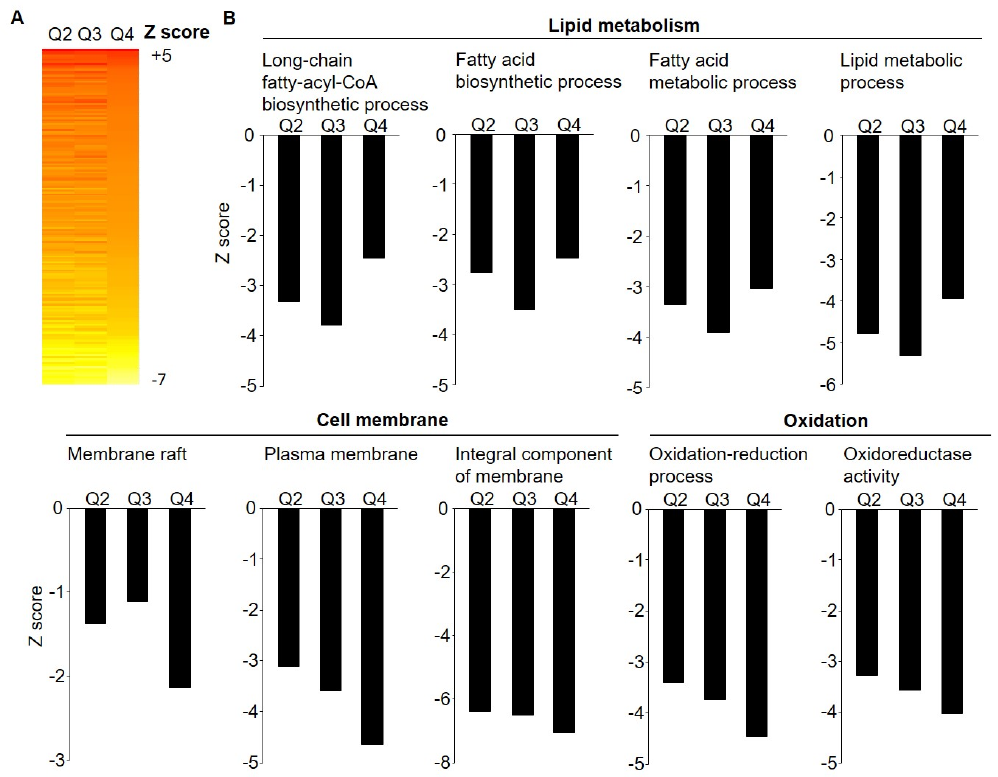
Figure 1. Effect of weight loss on SAT gene expression pathway enrichment ( n = 138). Parametric analysis of gene-set enrichment (PAGE) were performed on microarray data including 681 significantly ( p < 0.05) regulated genes across weight loss quartiles. ( A ) Heat map on biological pathways that were significantly differentially regulated by weight loss, based on the Z score for difference between weight loss quartiles with Q1 (lowest quartile) as a reference. ( B ) Biological pathways involved in lipid metabolism, cell membrane, and oxidation processes were significantly downregulated with weight loss. Further list of pathways see Table S2.